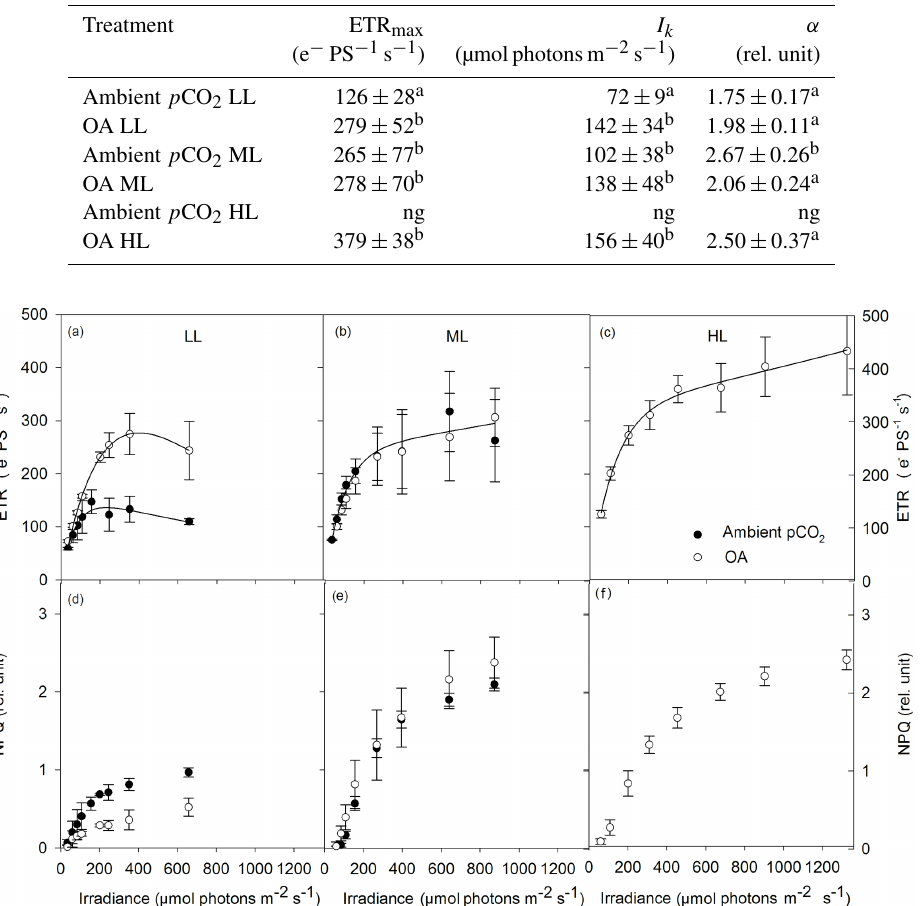
Figure 4. Absolute electron transport rates (ETR, a – c ) and non-photochemical quenching (NPQ, d – f ) were measured in response to in- creasing irradiance in Geminigera cryophila acclimated to ambient (black circles) or high CO 2 (white circles) conditions combined with (a) low (LL), (b) medium (ML) or (c) high light (HL). G. cryophila did not grow under ambient p CO 2 and HL. ETRs were obtained in three individual measurements. Values represent the means ± SD ( n =